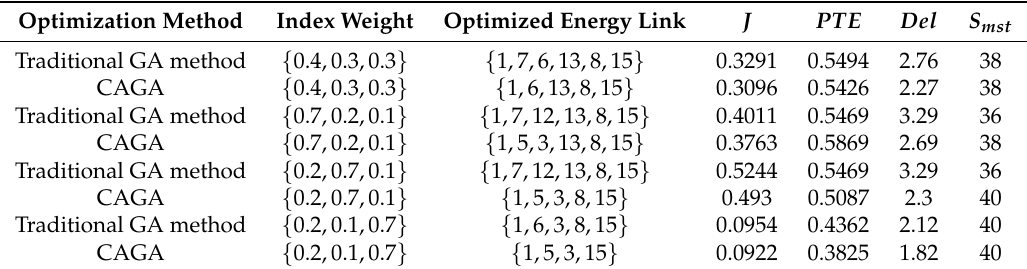
Table 3. Convergence results ( N =